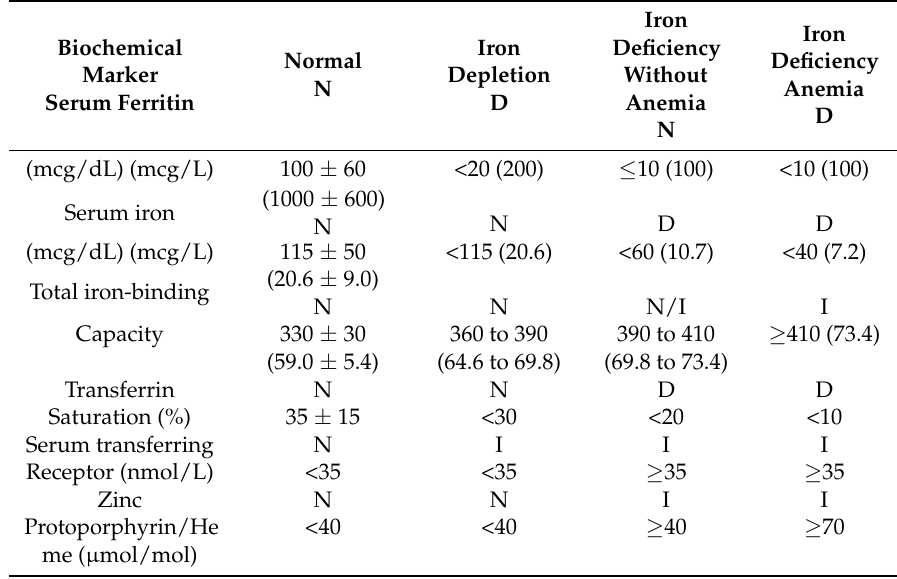
Table 1. Biochemical markers and their respective concentrations for iron deficiency anemia (IDA) screening